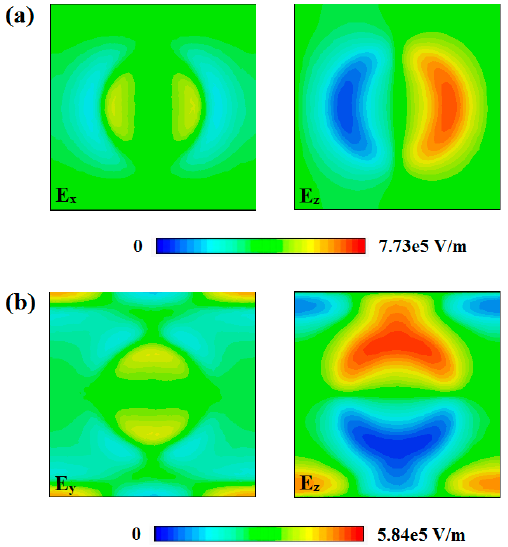
Figure 2. Calculated results for peak absorption frequency: ( a ) distribution of the electric field in the LC layer under TE-polarized normal incidence at 238.4 GHz; ( b ) distribution of the electric field in the LC layer under TM-polarized normal incidence at 313.2 GHz.